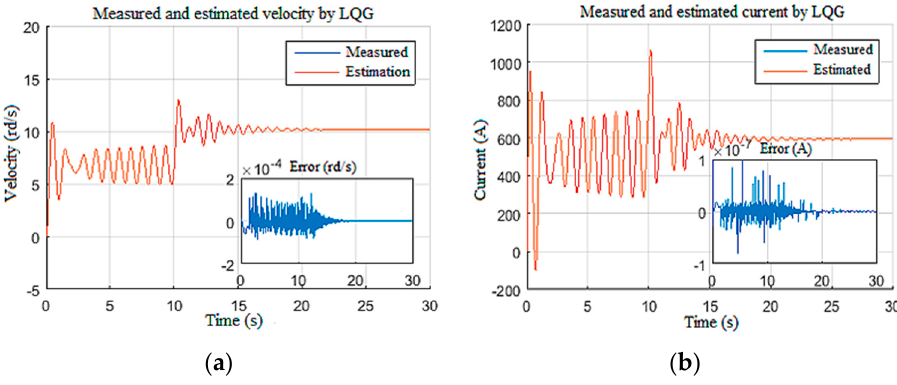
Figure 13. Top drive responses for Scenario 1: ( a ) velocity; ( b ) current.